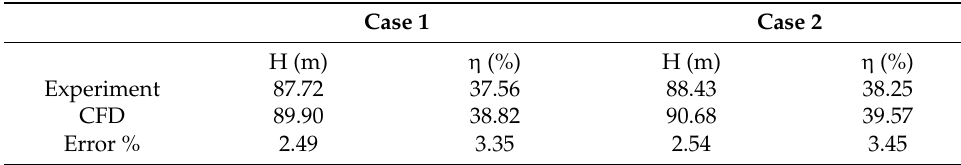
Table 2. Two startup conditions. Table 3. Comparison between the experimental results and those of